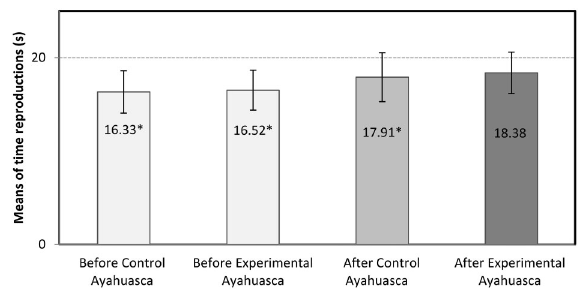
Figure 1. Means and standard deviations of time reproductions before and after control and experimental ayahuasca conditions. *P o 0.05 compared to the 20 s musical stimuli (dotted line) (Student ’ s t